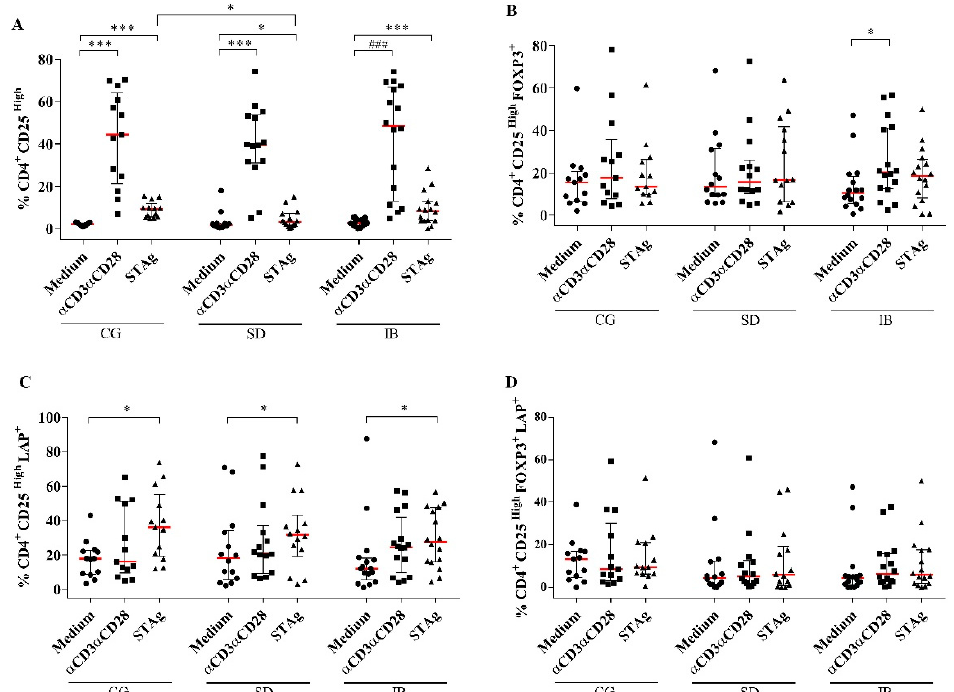
Figure 6. Regulatory CD4 + T lymphocytes profile, evaluated by the expression of the alpha chain of the IL-2 receptor (CD25), LAP, and the transcription factor Foxp3. ( A ) Percentage of the total CD4 + CD25High, ( B ) CD4 + CD25High Foxp3 + , ( C ) CD4 + CD25High LAP + , and ( D ) CD4 + CD25High Foxp3 + LAP + after 96 h of stimulus with anti-CD3 and anti-CD28, STAg, and absence of stimulus in the CG and SD and IB groups, by flow cytometry. Analysis between stimuli by Wilcoxon and among groups by Kruskal–Wallis. The horizontal bars represent the medians with interquartile ranges. Statistically significant data, * p < 0.05, ** p < 0.005, *** p < 0.0005, and ### p < 0.0001. CD4 + CD25HighFoxp3 + cells had an increase in their percentage in the